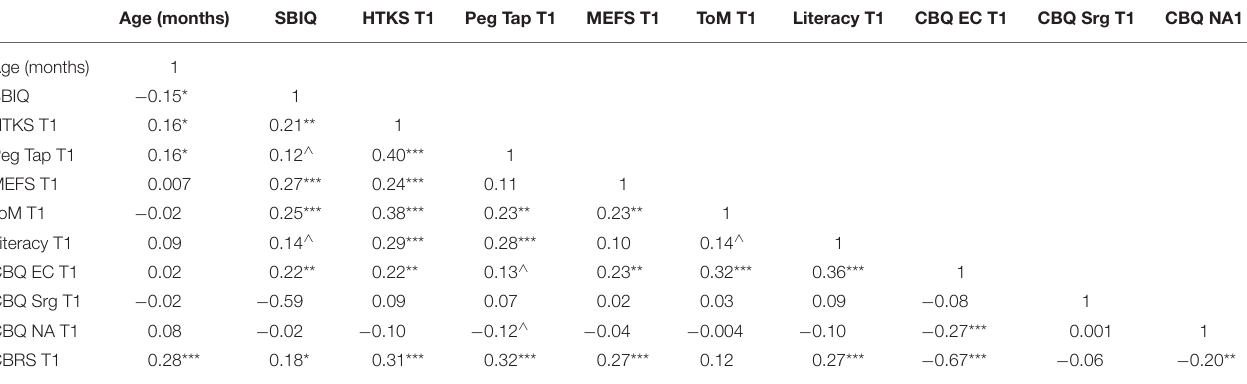
TABLE 4 | Bivariate correlations among pre-test (time 1) measures. Age (months) SBIQ HTKS